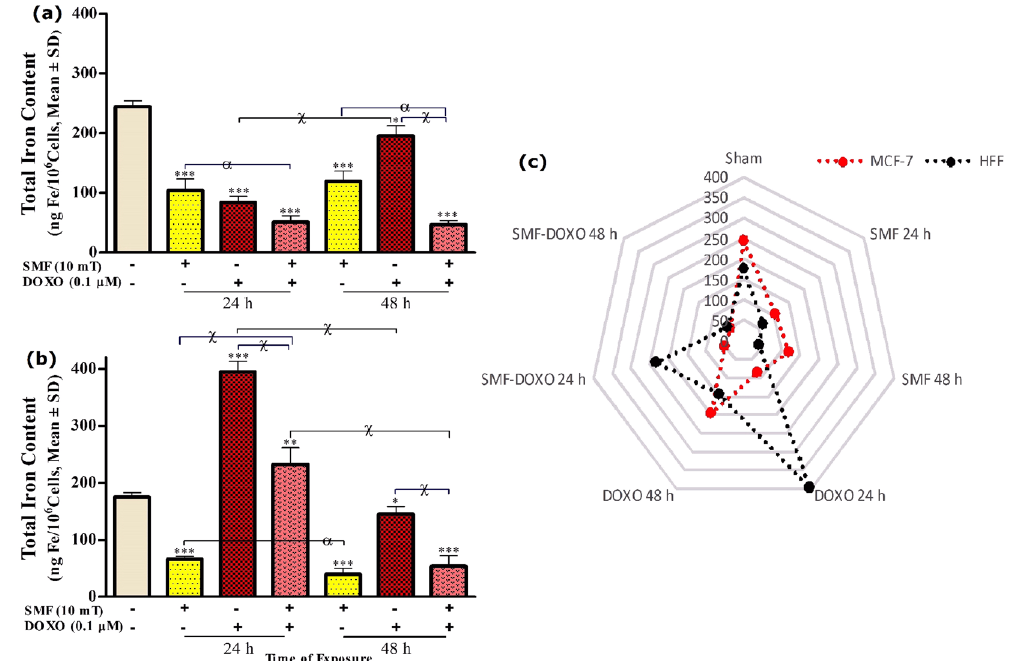
Figure 4. The intracellular iron results of ( a ) MCF-7, ( b ) HFF cells and ( c ) both comparison exposed with 10 mT SMF and incubated with 0.1 μ M DOXO for two exposure times (24 and 48 h). The total iron was quantified by ICP-OES, and results are expressed as the concentration of iron content (ng Fe per 10 6 cells). Data are shown as mean ± SD (n = 3). * P < 0.05; ** P < 0.01; *** P < 0.001 . Significant difference relative to unexposed cells (sham; was measured at 48 h), and letters ( α , P < 0.05; x, P < 0.001) . Significant differences between treated cells (2 × 2 × 2 factorial ANOVA flowed by post-hoc Newman–Keuls multiple comparison